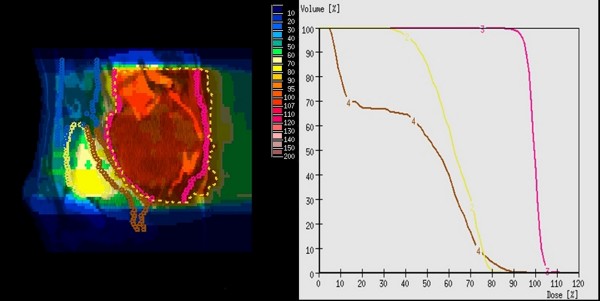
Sagittal dose distribution and DVH information in patient 5. graphs: PTV (3), rectum (4), bladder (5)